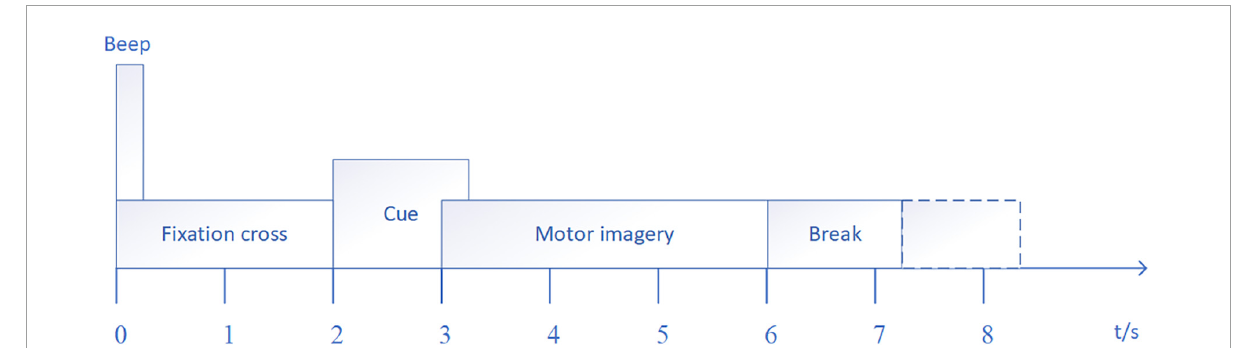
FIGURE4 Experimental paradigm.